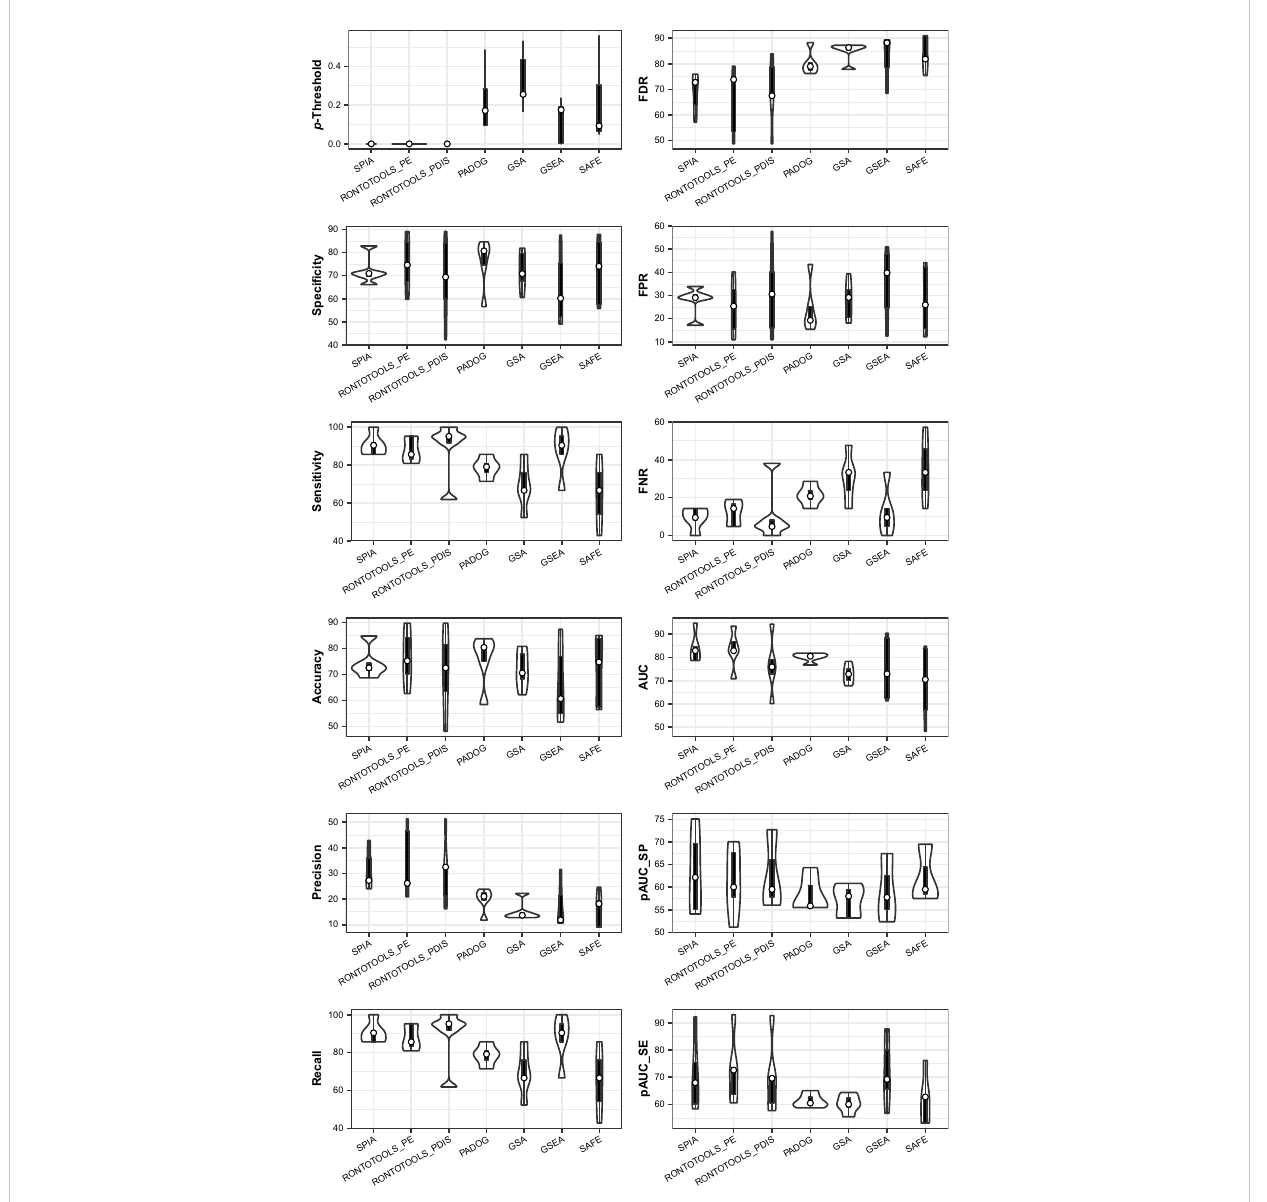
FIGURE 12 Violin plot of key metrics indicates the performance difference of seven methods when benchmarked on a collection of fi ve data. The topology- based methods (SPIA, ROntoTools_PE and ROntoTools_pDIS) generally perform better than the non-topology-based methods (GSEA, GSA, SAFF and PADOG). SPIA is overall better than ROntoTools_PE and